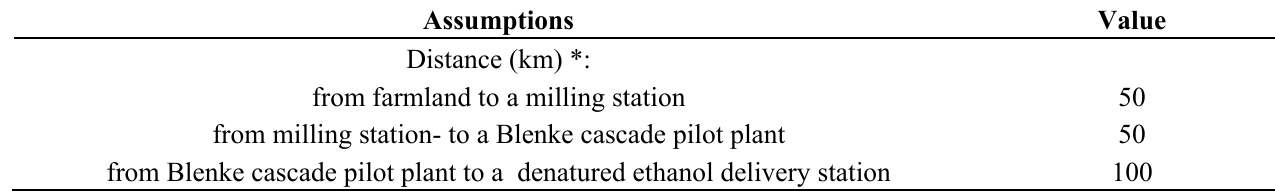
Table A2. Parameters used in the life cycle analysis at the second stage (transportation).